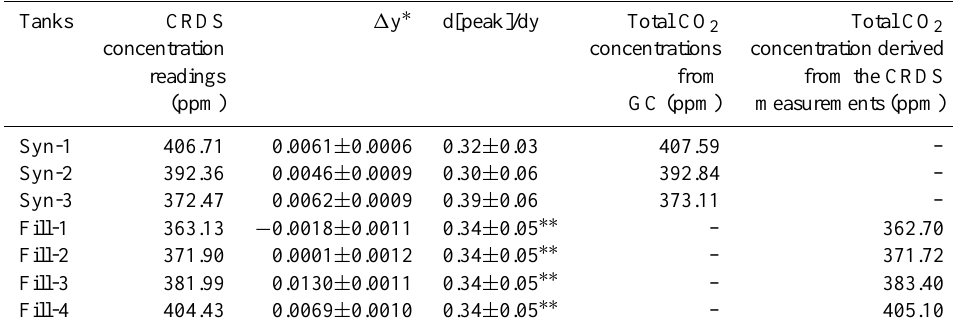
Table 2. Total CO 2 concentrations of the four filling tanks used during BARCA, derived from the laboratory experiments of measuring synthetic air standards with known total CO 2 concentrations from